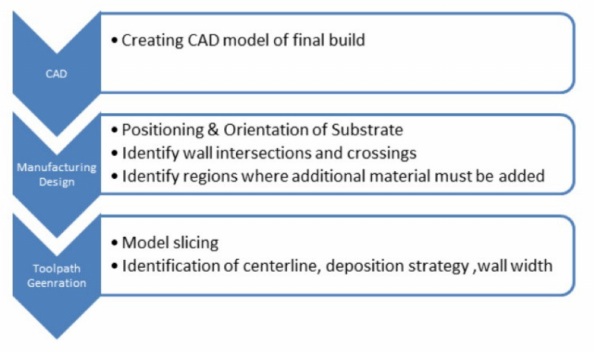
Figure 2. Automated Planning Sequence for